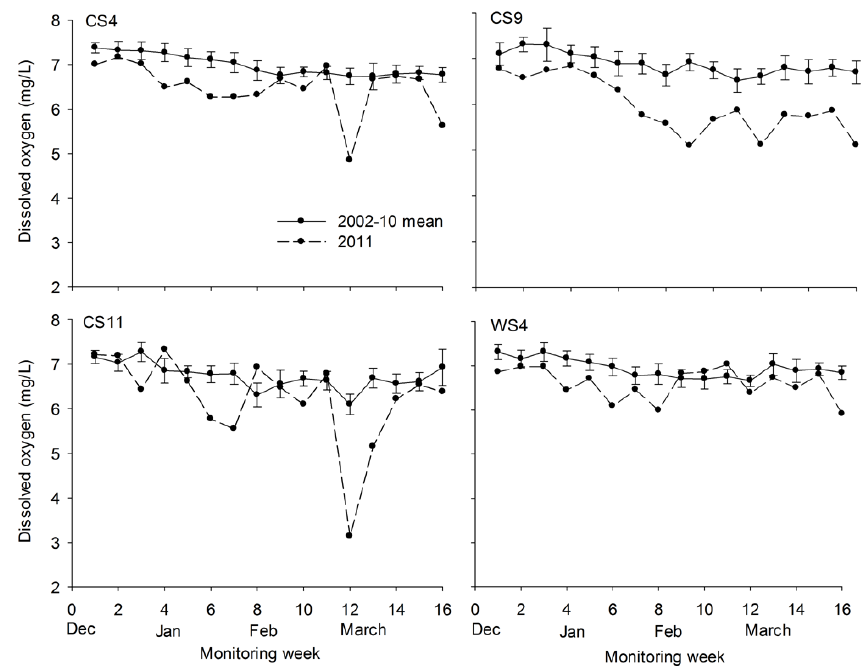
Fig. 4. Weekly dissolved oxygen (DO) recorded during 2011, plotted against 2002–2010 mean DO ( ± SE) at each monitoring site (“monitoring week 1” relates to the first week in